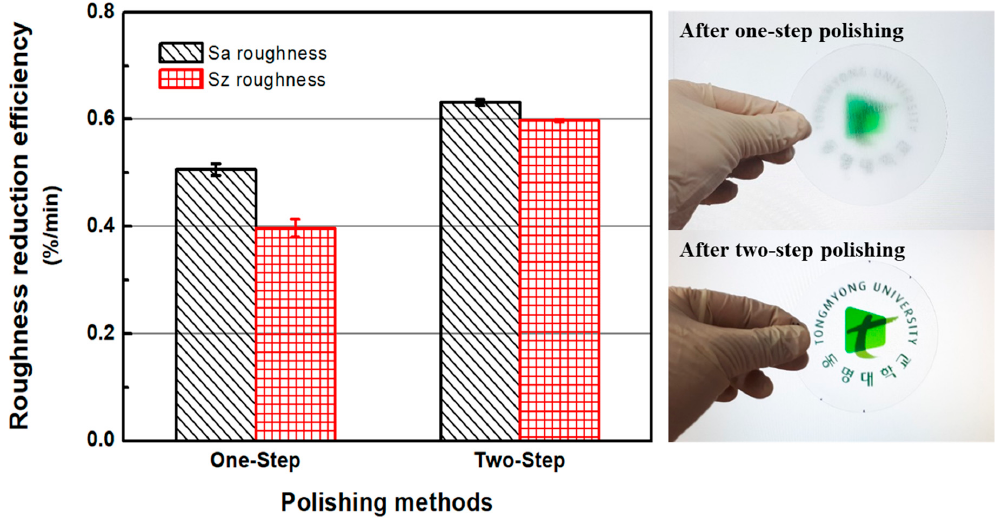
Figure 14. Roughness reduction efficiencies of one-step and two-step polishing methods and pictures of ABS-like resin disks after one-step polishing and two-step polishing (polished on both sides).